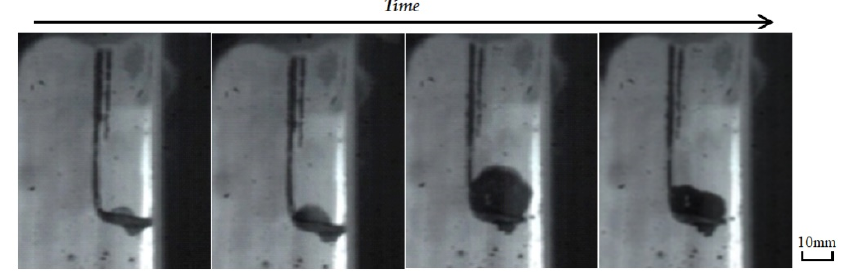
Figure 5. The volume expansion of the waste liquid droplets.